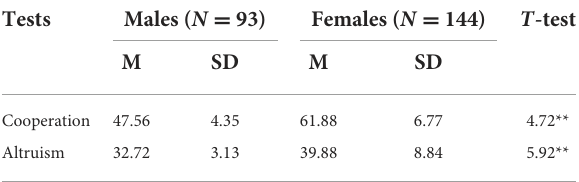
TABLE 3 Mean scores, standard deviations, and t -test values of males and females in cooperation and altruism.